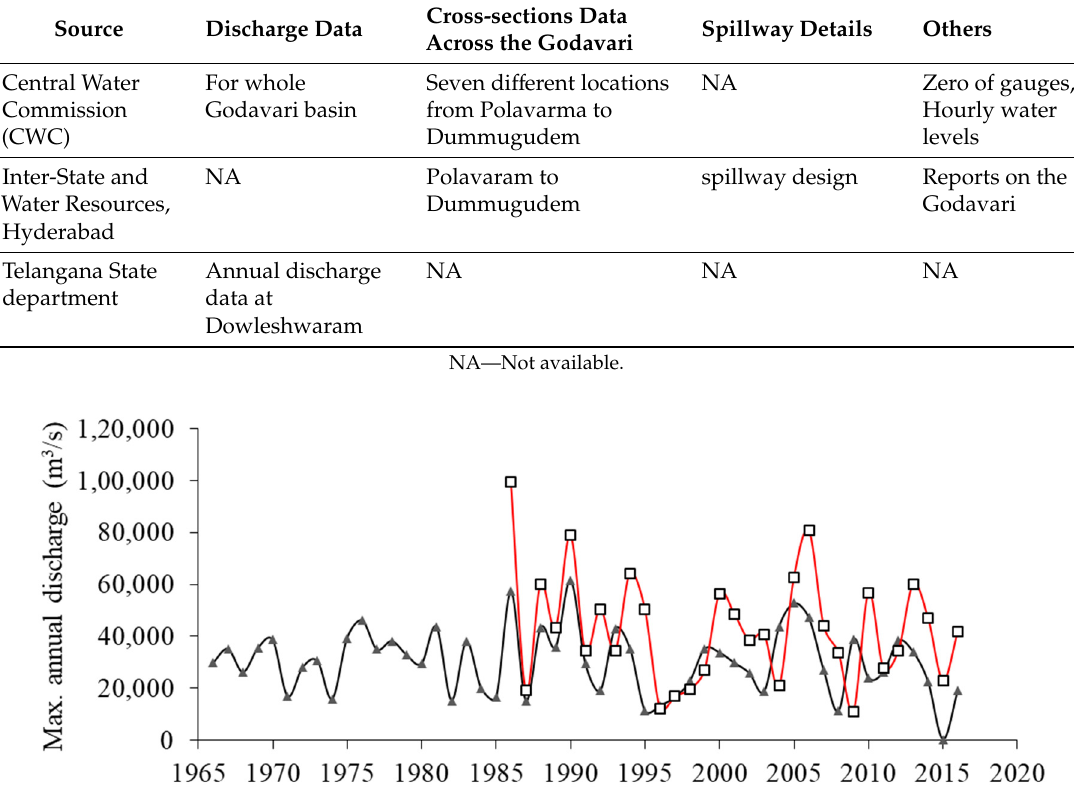
Table 1. List of Data collected from di ff erent sources.